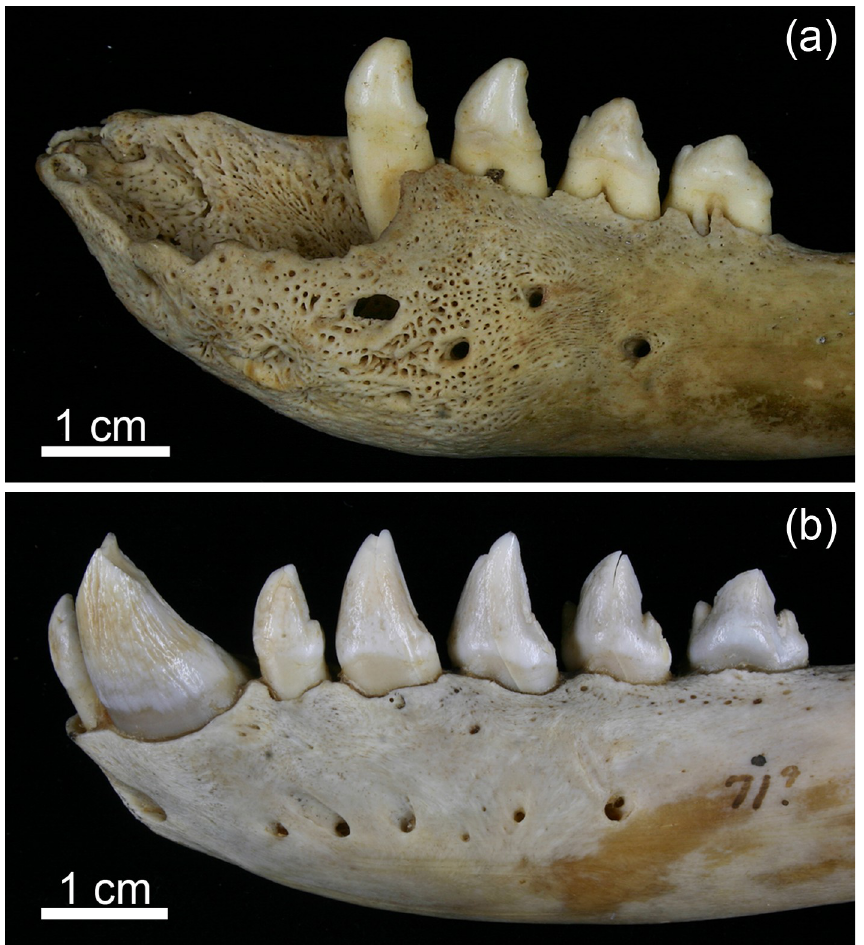
Fig 9. Lateral views of the anterior regions of the left mandibles of two juvenile Baltic grey seals ( Halichoerus grypus grypus ) from the 19th century. (a) Specimen ZMUC 139; I 1 , I 2 , C and P 1 are missing, most likely due to intravital loss. Note widened alveolus of the mandibular C and enlargement of the mandible due to apposition of periosteal new bone with numerous small vascular foramina. Porous bone has also been deposited on the wall of the enlarged alveolus. Some of the mental foramina appear enlarged. The changes are indicative of a severe inflammatory process in the anterior mandible. (b) Specimen ZMUC 71 9 , showing the normal condition of the mandible for comparison.